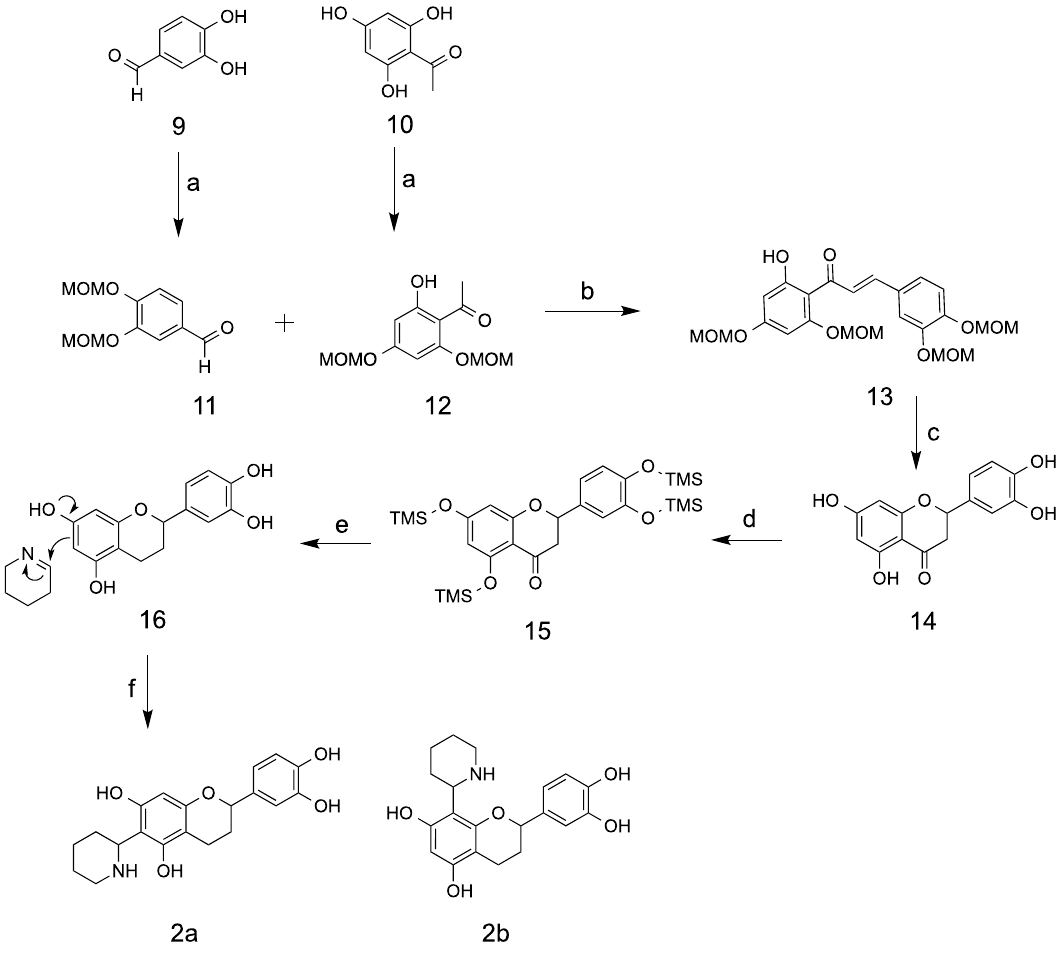
Scheme 2. Route one for the synthesis of kinkeloids B. Reaction conditions and reagents: ( a ) DIPEA, MOMCl, DMAP, CH 2 Cl 2 , 0 °C to RT (88% for 11 , 74% for 12 ); ( b ) 40% KOH, ethanol, 0 °C to RT (62%);